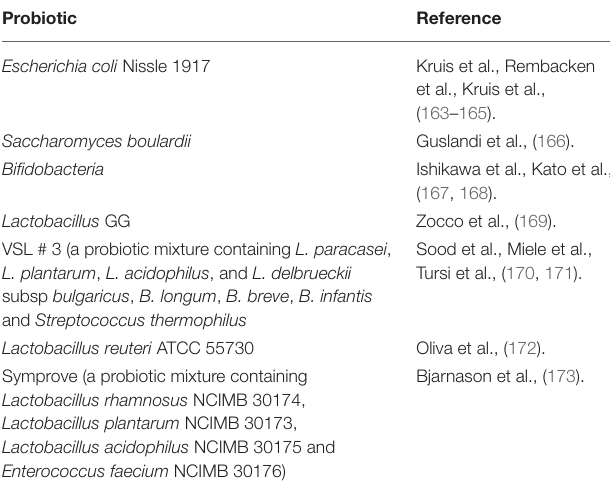
TABLE 3 | Probiotics with proven therapeutic potential for